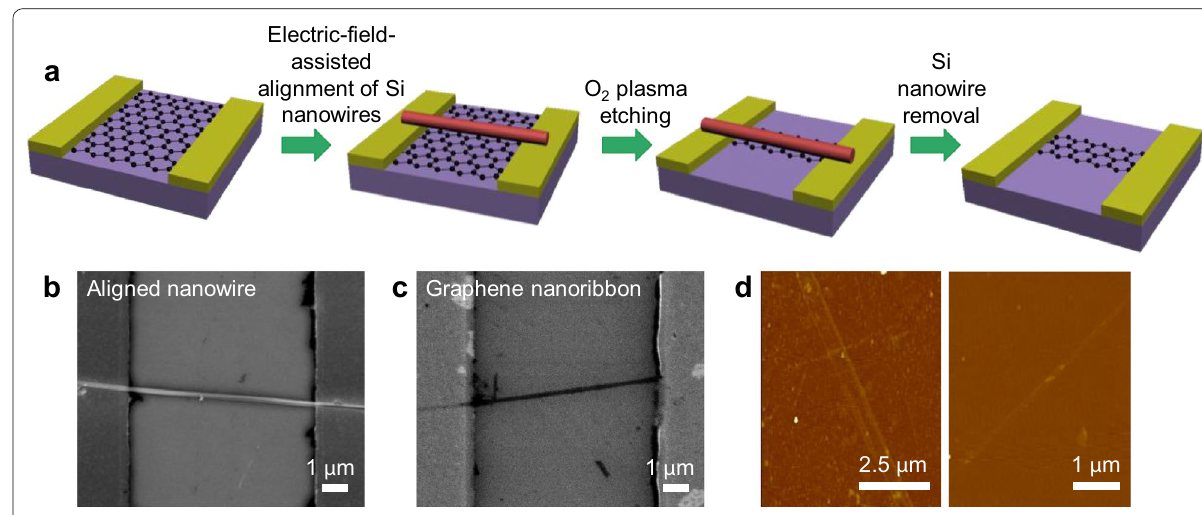
Fig. 4 a Schematic illustration of the fabrication of a GNR FET using a Si NW as a hard etch mask. FESEM images of b a Si NW aligned on graphene between two electrodes, where unscreened graphene was removed, and c a GNR after the removal of the Si NW. d AFM images of GNRs with two different ribbon widths (left: 500 nm and right: 100 nm)